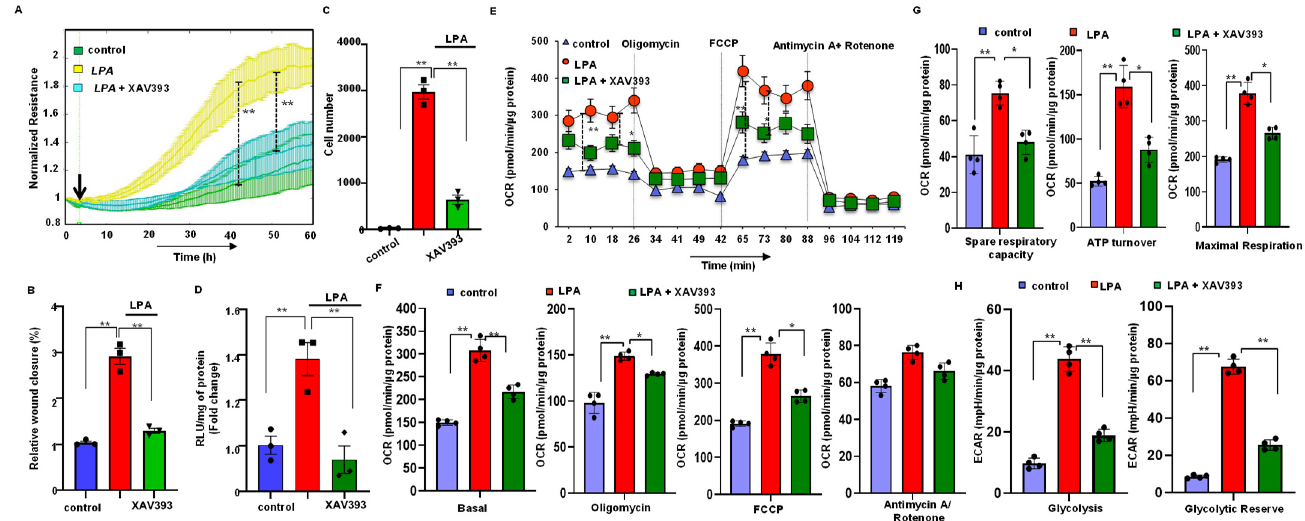
Figure 6. Axin stabilization attenuated LPA-induced progression, β -catenin activation, and mito- chondrial energy metabolism in gastric cancer cells. ( A ) Effect of XAV393 on LPA-stimulated ECIS proliferation activity in the AGS cell line ( n = 3). Green line, control; yellow line, 10 µ M LPA; turquoise blue line, LPA+ XAV393. ( B ) Scratch assay analysis of the antagonist effect of XAV393 on LPA-induced migration in gastric cancer cells. Quantified wound closure rate after 24 h of exposure to LPA in the presence and absence of XAV393 in AGS cells. ( C ) XAV393 reduced LPA-induced invasive activity in gastric cancer cells. Quantification of the results of the invasion assay. ( D ) Luciferase assay examining the effect of XAV393 in AGS cells. RLU, relative light unit. ( E , F ) Representative graphs and quantification of OCR measurement in control (no LPA), LPA-treated, LPA + XAV393-treated AGS cells showing basal OCR and after sequential addition of oligomycin, FCCP, and antimycin + rotenone. ( G ) Quantification of spare respiratory capacity, ATP turnover, and maximal respiration after treating the AGS cells with control (no LPA), 10 µ M LPA, LPA +XAV393. ( H ) ECAR analysis of the AGS cell line after treating the AGS cells with control (no LPA), LPA, LPA + XAV393. The bar graphs represent glycolysis and glycolytic reserve. All values are mean ± SD ( n = 3). * p < 0.05, ** p < 0.01; one-way ANOVA) followed by the Bonferroni post hoc